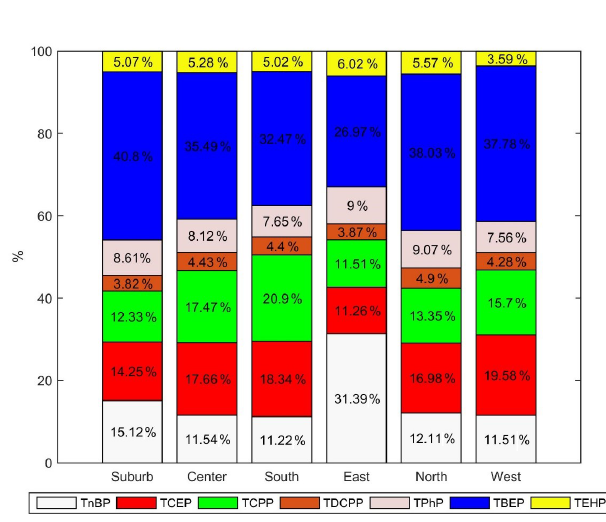
Figure 2. Percentages of individual OPEs contributing to the (cid:54) 7 OPEs at each sampling